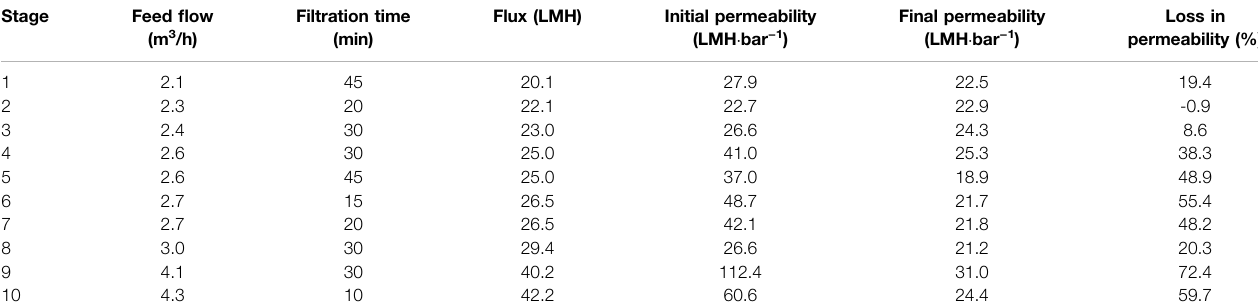
TABLE 2 | Summary of operational parameters set during the 10 operation stages of UF.